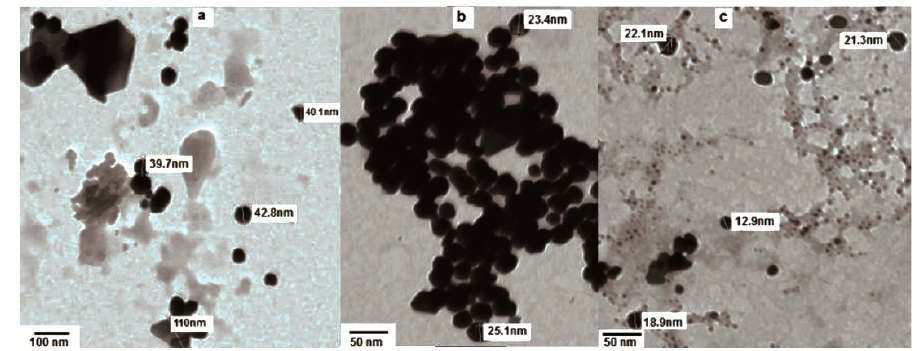
Figure 4. TEM image of Au NPs treated for 1 h with ( a ) 3 mL of extract and 0.7ml HAuCl 4 .3H 2 O and ( b , c ) 3 mL of extract and 0.5 mL HAuCl 4 .3H 2 O.